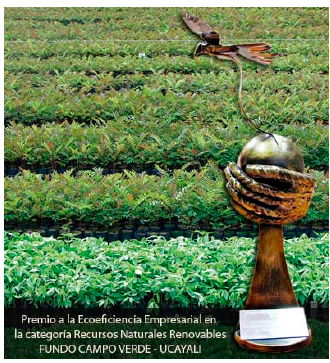
Figure 19. Eco-Efficiency Business Award. Figure 19. Eco-E ffi ciency Business